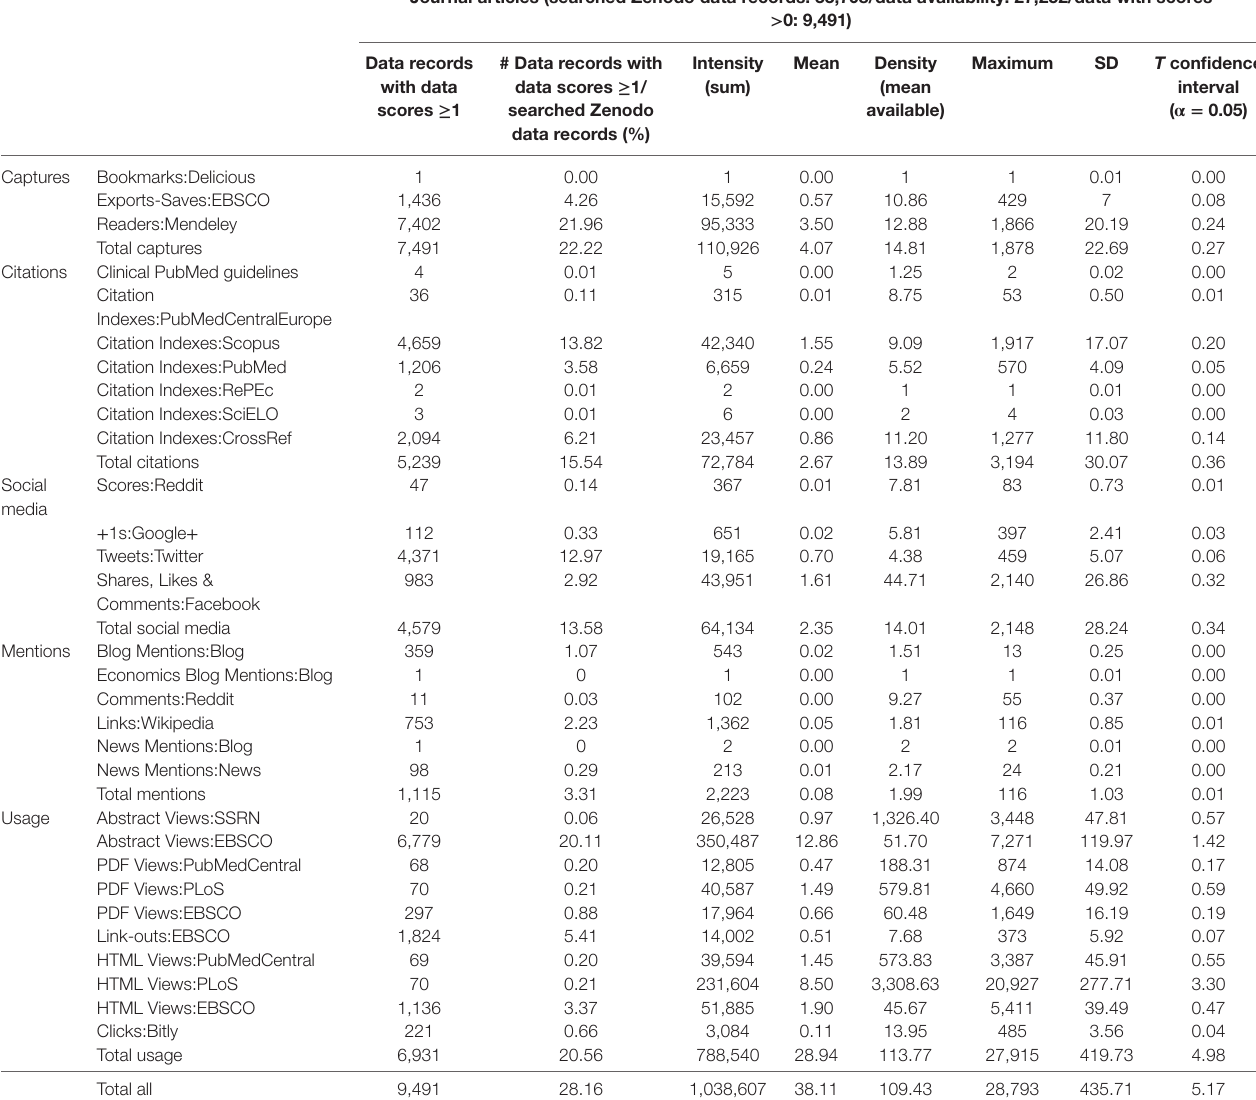
Table 5 | Results from PlumX (Zenodo data record type: journal articles; all publication years; see also Tables A1–A7 in Supplementary